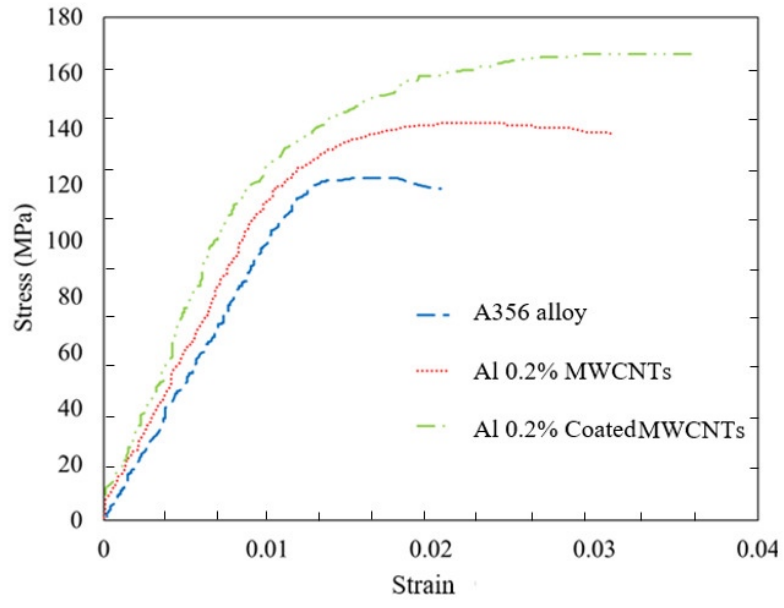
Figure 7. Stress–strain diagram of A356 aluminum alloy and 0.2% by mass nanocomposites with and without a coating of reinforcing particles.